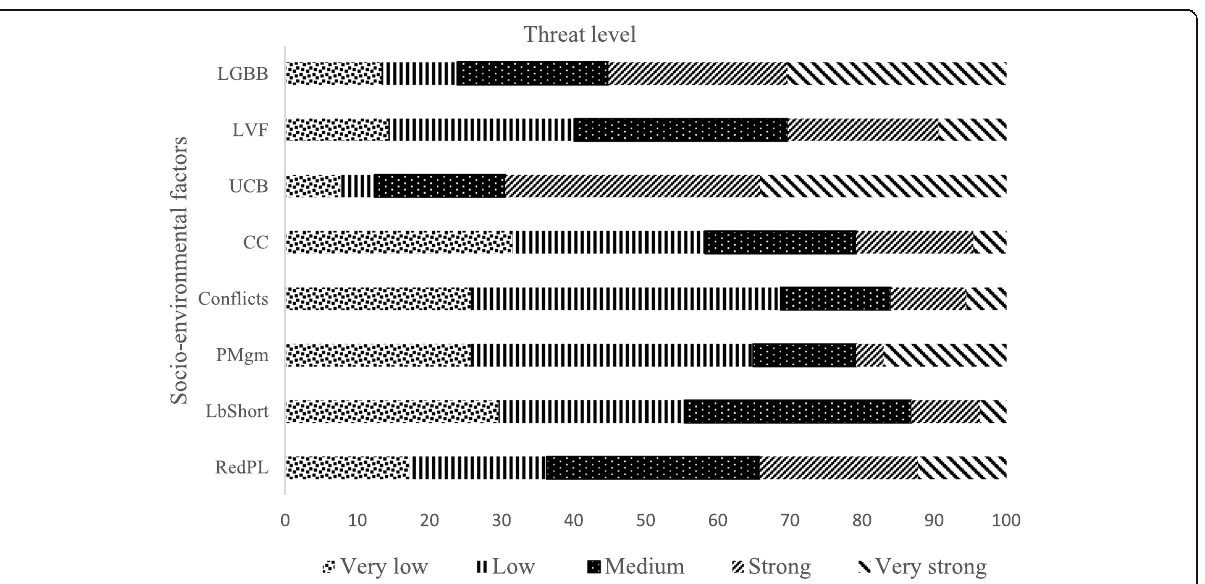
Fig. 3 Perceived threat level from the socio-environmental factors. LGBB lack of good breeding bulls, LVF lack of veterinary follow-up, UCB uncontrolled cross-breeding, PMgm poor management, RedPL reduction of pasture lands, LbShort labour shortage, CC climate